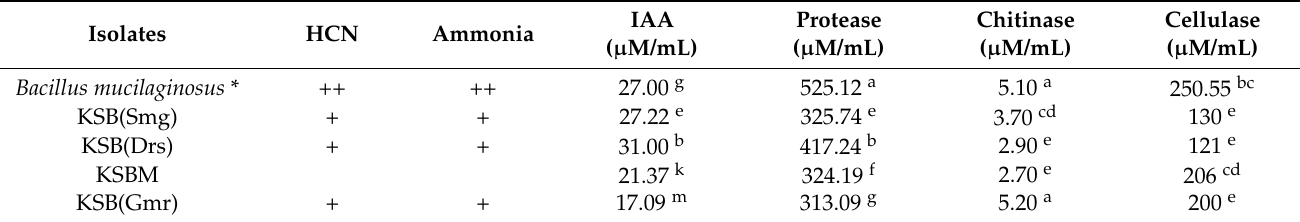
Table 5. Production of plant growth-promoting substances and enzymes by K solubilizing bacteria.